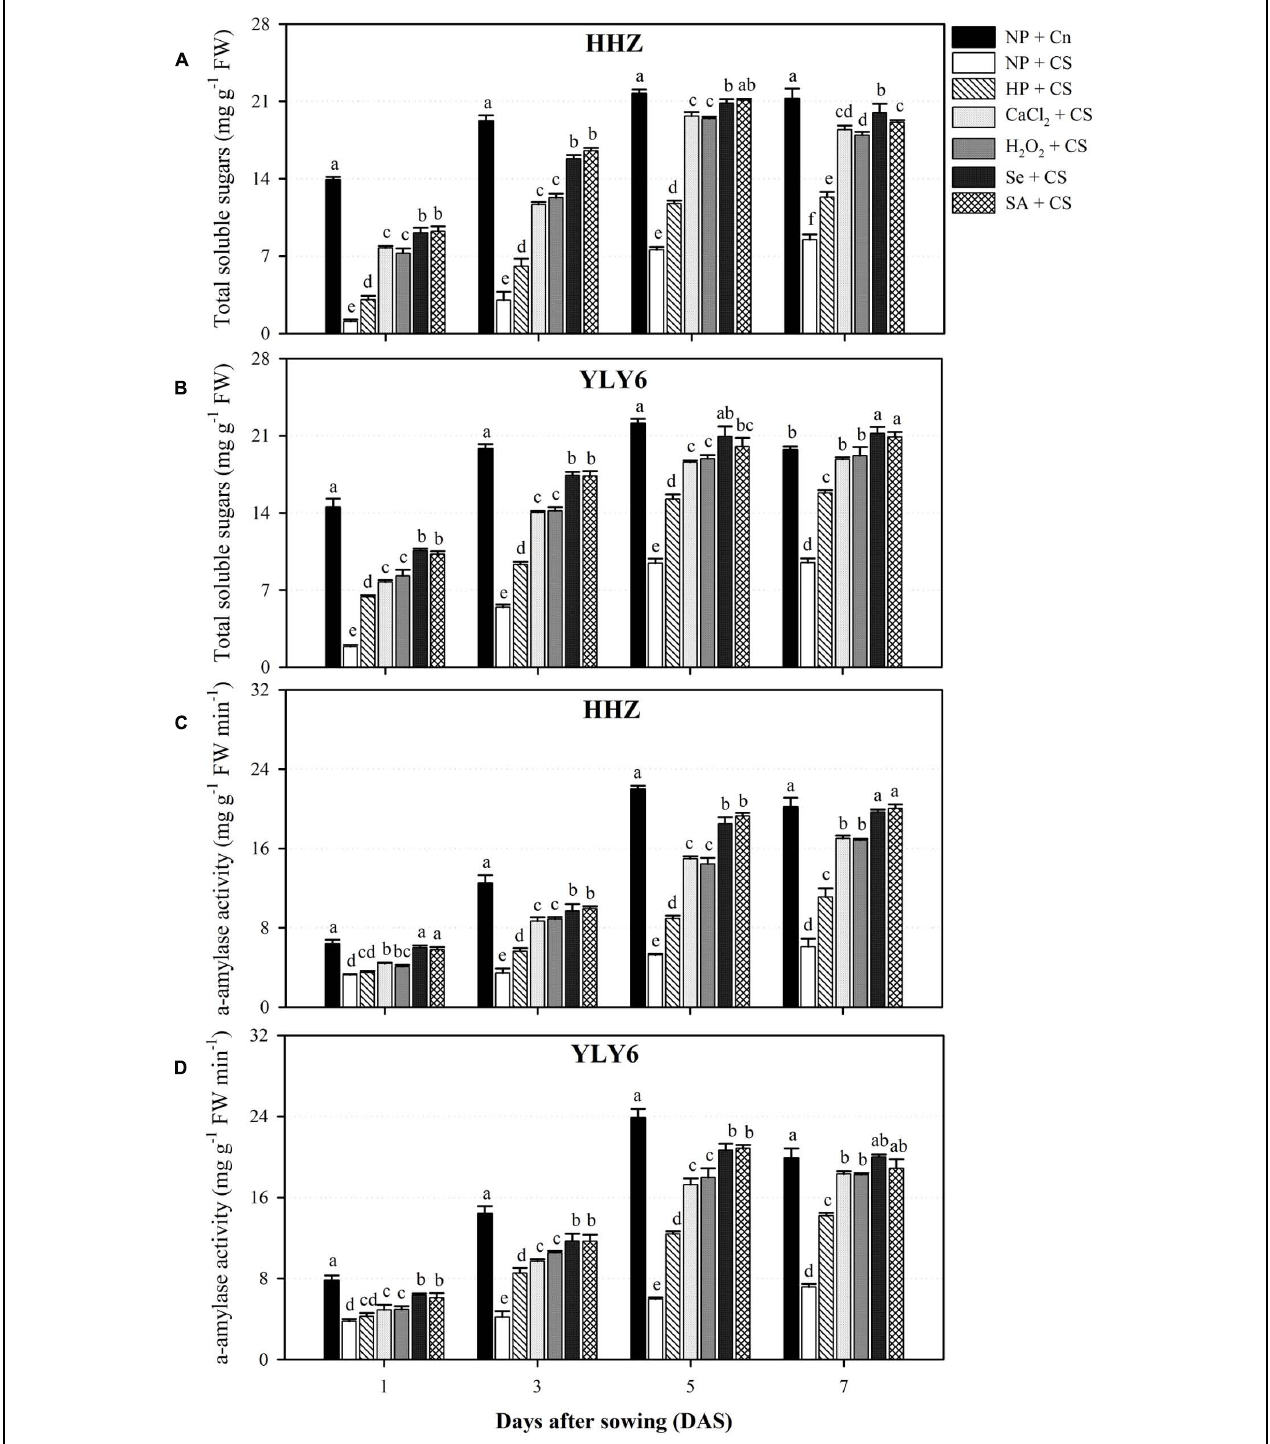
FIGURE 3 | Influence of various seed priming treatments and chilling stress on starch metabolism at 1, 3, 5, and 7 DAS in two cultivars. (A) total soluble sugars in HHZ, (B) total soluble sugars in YLY6, (C) α -amylase activity in HHZ, and (D) α -amylase activity in YLY6. Vertical bars above mean indicate standard error of six replicates. Mean value for each treatment with different lowercase letters indicate significant differences by the LSD-test ( P < 0.05). NP + Cn: no priming and no stress, NP + CS: no priming and chilling stress, HP + CS: hydropriming and chilling stress, CaCl 2 + CS: calcium chloride priming and chilling stress, H 2 O 2 + CS: hydrogen peroxide priming and chilling stress. Se + CS: selenium priming and chilling stress, and SA + CS: salicylic acid priming and chilling stress, Cn: 28 ◦ C, CS: 18 ◦ C, HHZ: inbred cultivar huanghuazhan, YLY6: hybrid variety Yangliangyou-6.